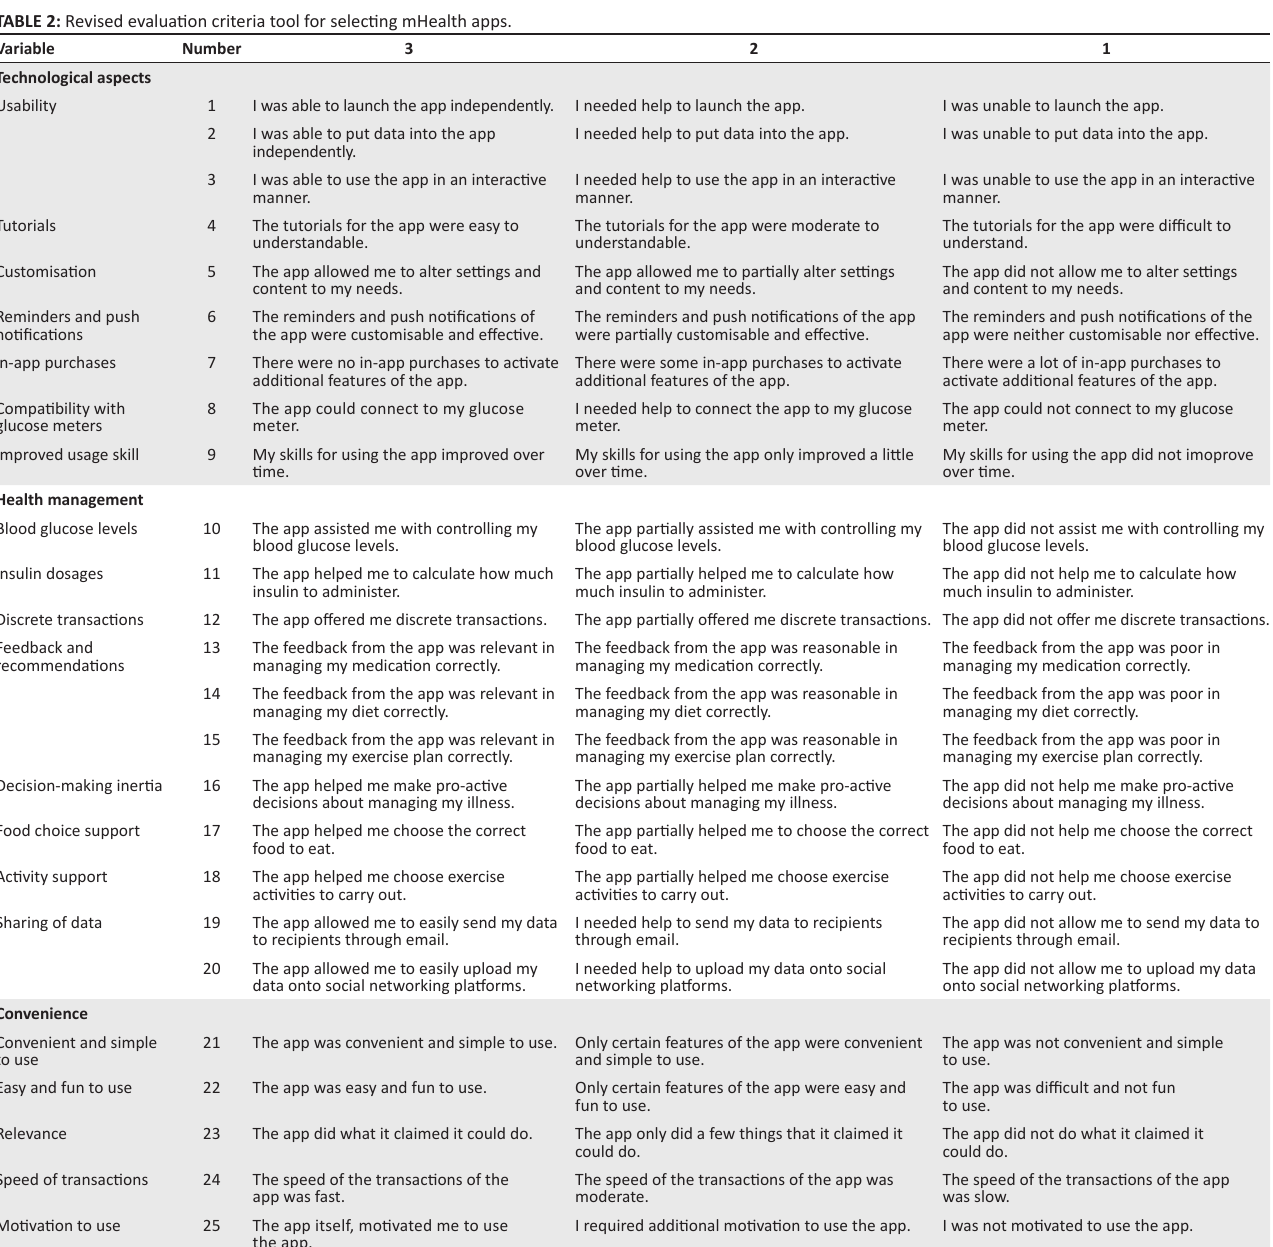
TABLE 2: Revised evaluation criteria tool for selecting mHealth